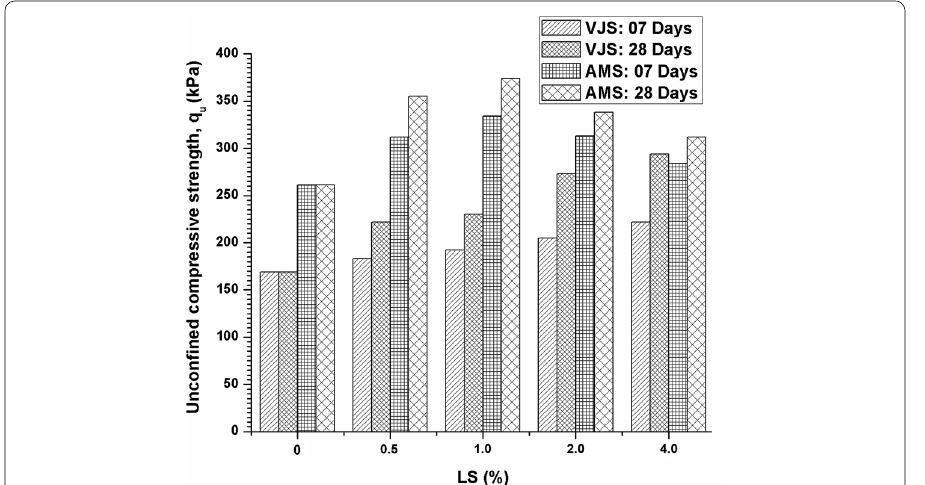
Fig. 1 Unconfined compressive strength of lignosulfonate treated